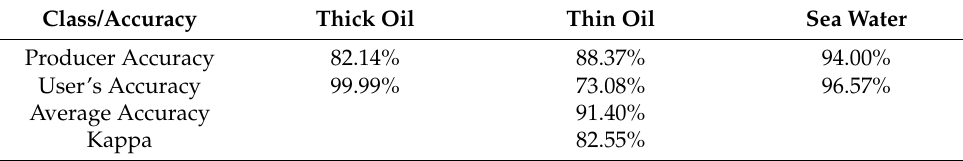
Figure 19. Random forest classification result graph and variable importance ranking for Case 6. Table 8. Classification accuracies of random forest classifier in Case 6.